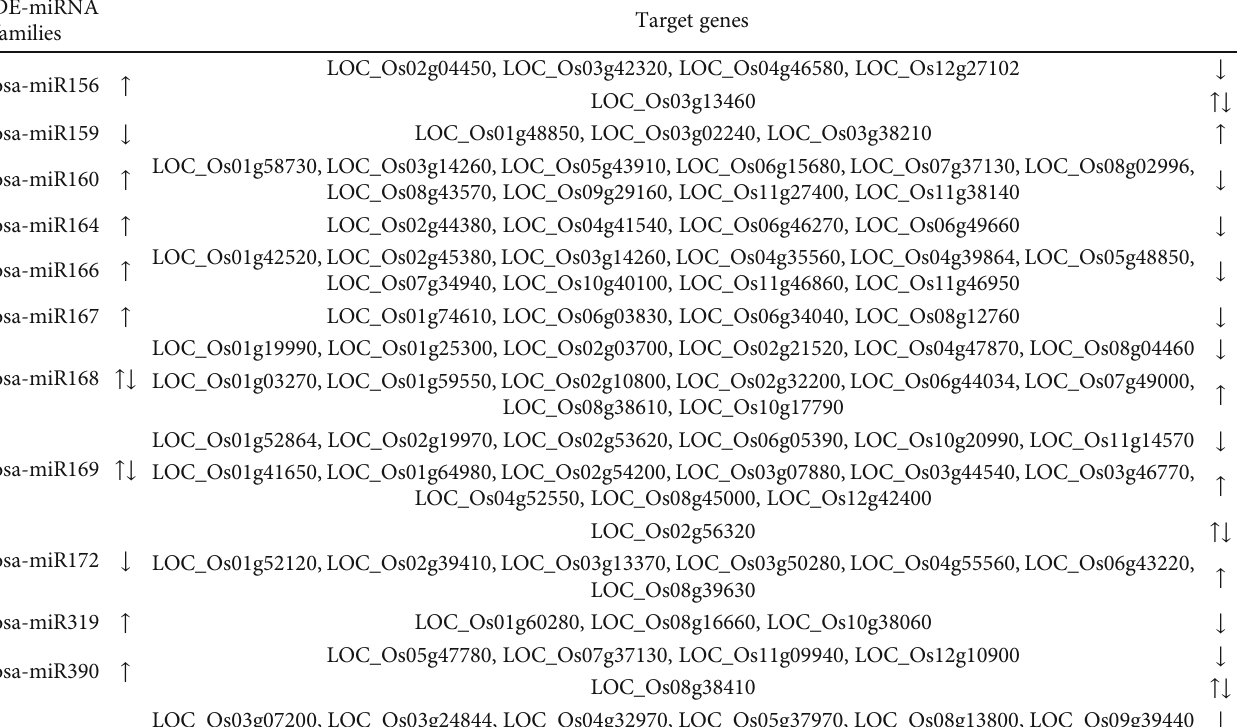
Table 1: High-con fi dence miRNA target pairs in rice post-meiosis panicle under the heat